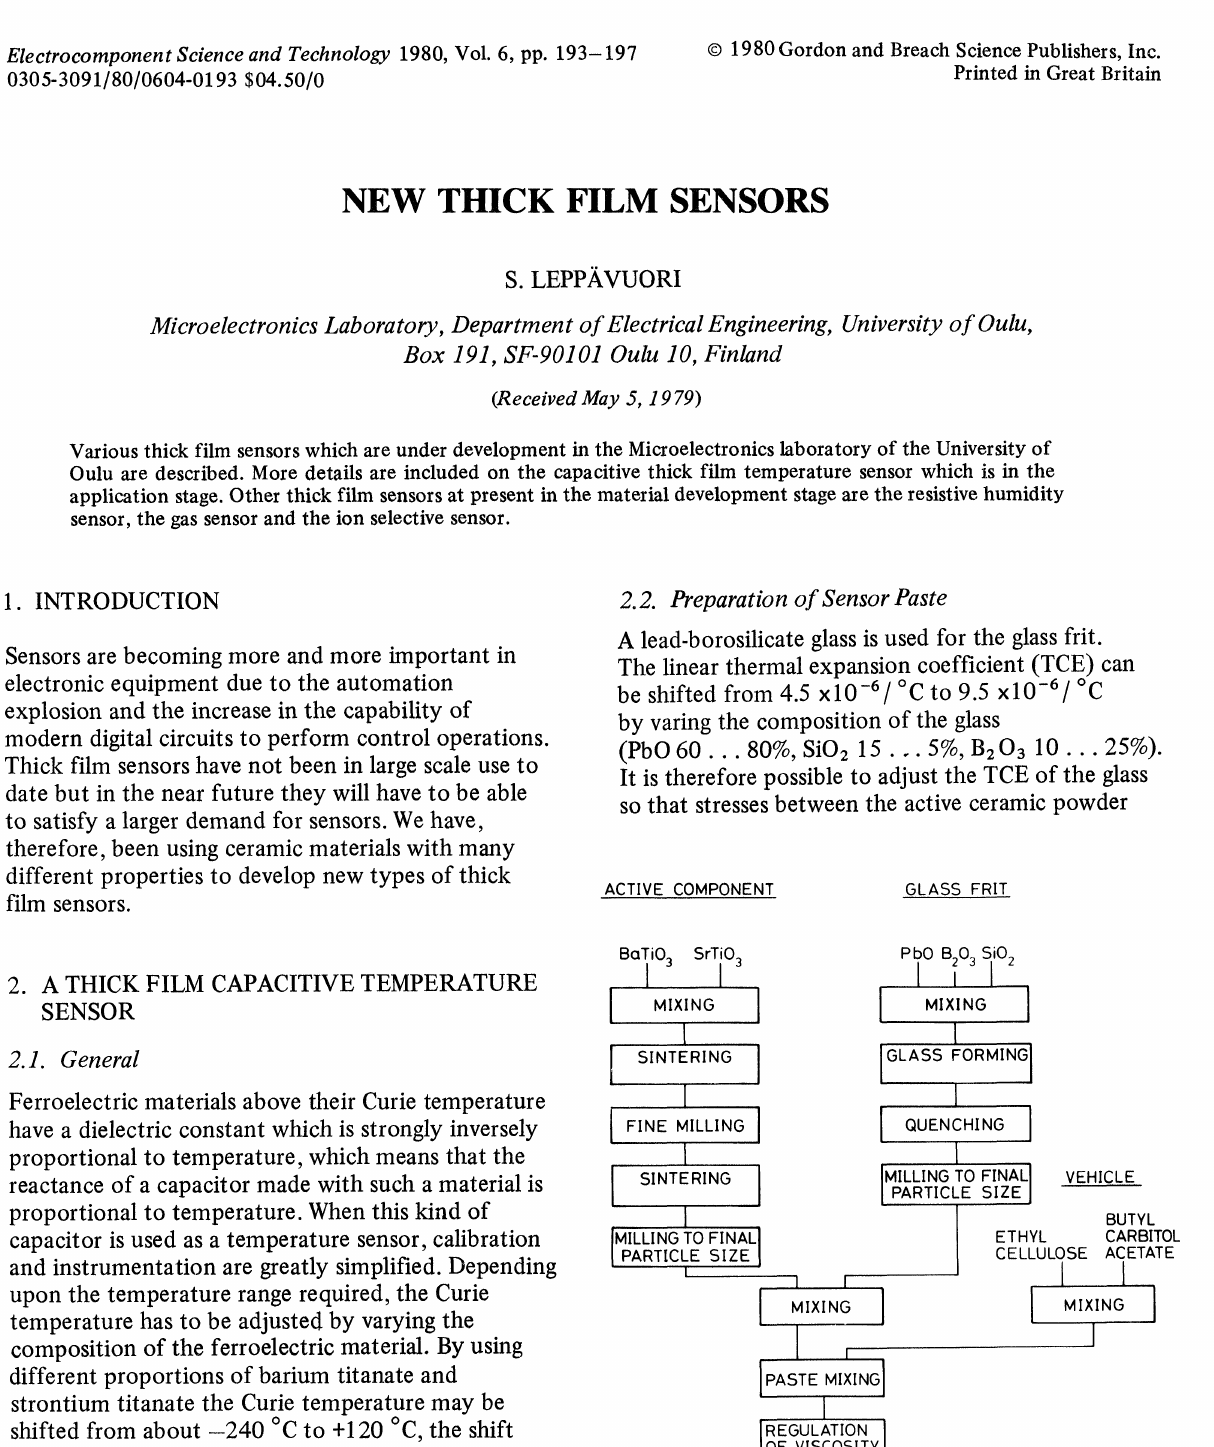
Preparation of sensor